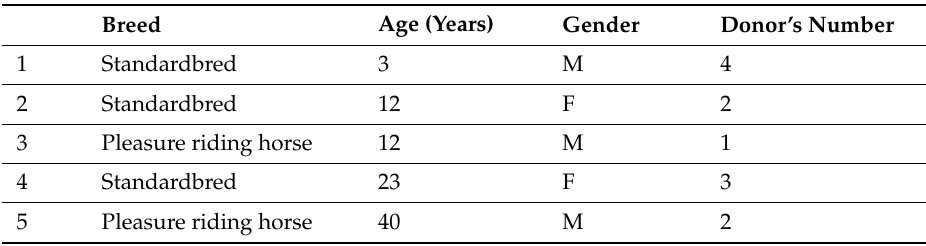
Table 1. Profiles of Sf samples obtained from the joints of horses of di ff erent ages. Breed